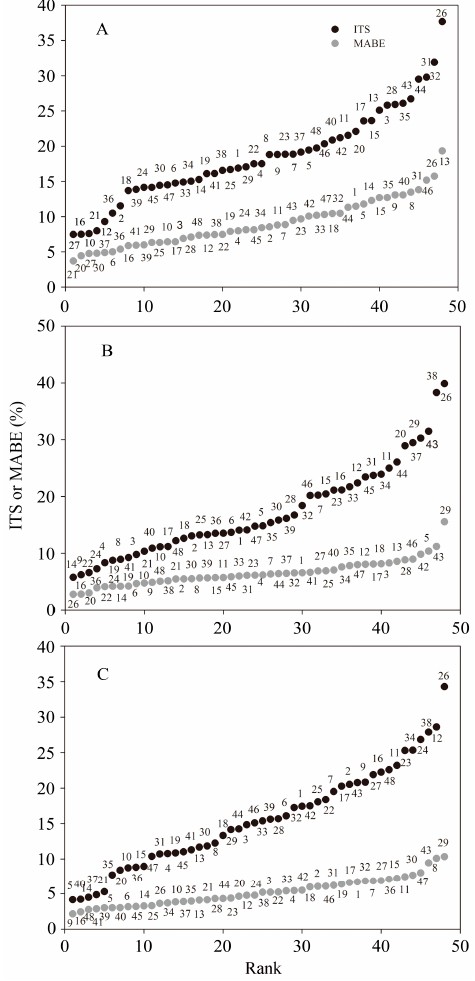
Figure 8. Ranked index of time stability (ITS) and mean absolute bias error (MABE) in the soil layers of 0–20 cm ( A ), 20–40 cm ( B ), and 40–60 cm ( C ).